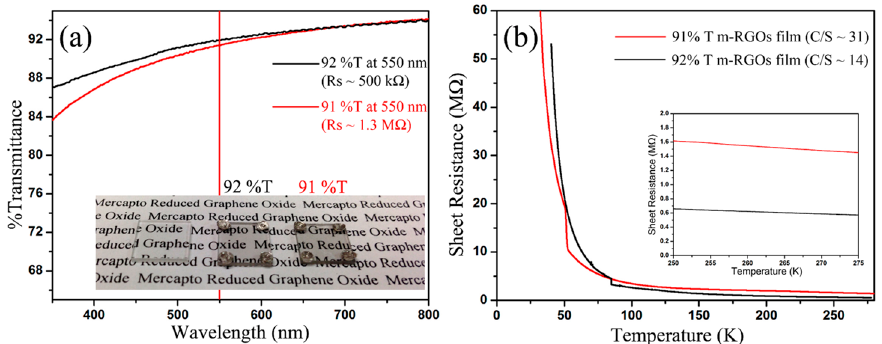
Figure 6. ( a ) Optical and ( b ) electrical properties of mRGO-180 LB film.